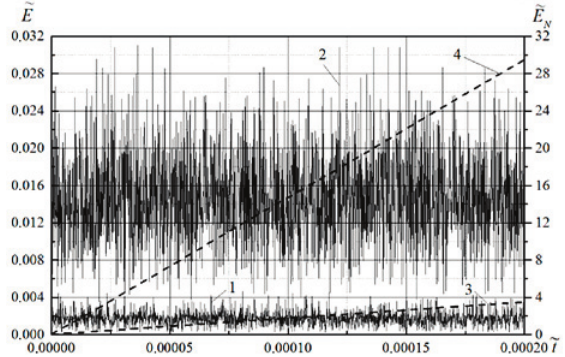
Fig. 2. Diagrams of variable energy E  (1, 2) and accumulated  (3, 4) of resulting acoustic emission signals and energy N E their time characteristics according to expression (2), where α  equals 300 and α  equals 600. Modelling parameters according to expression (1) are the following: 0 υ  =10 6 ;